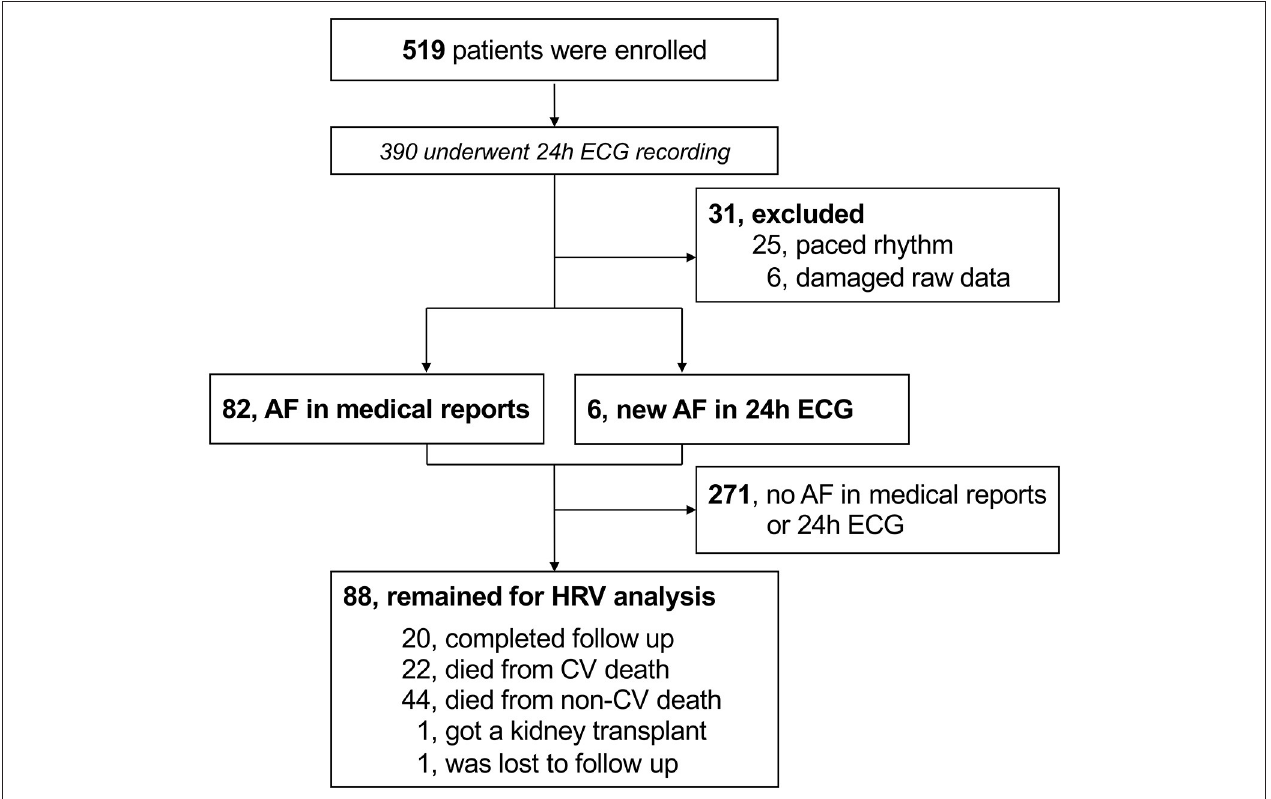
FIGURE 1 | Flow-chart of participants. AF, atrial fibrillation; CV, cardiovascular; ECG, electrocardiogram; HRV, heart rate variability.